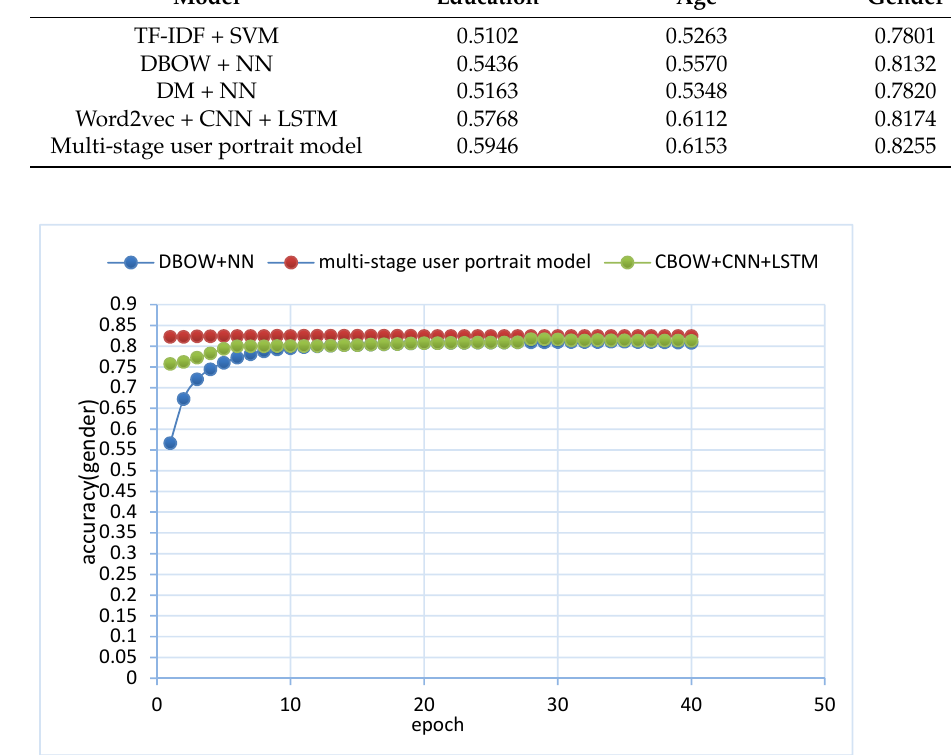
Figure 8. The variation diagram of iteration times and accuracy.